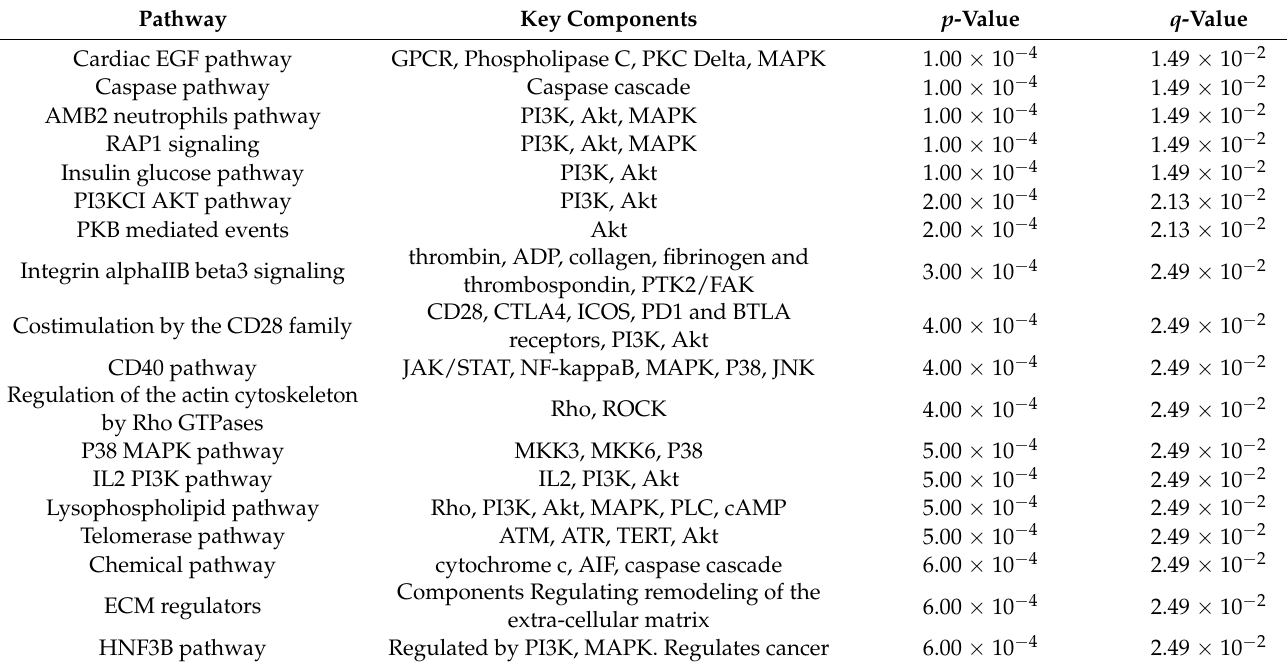
Table 3. Differentially regulated pathways between lipoma and